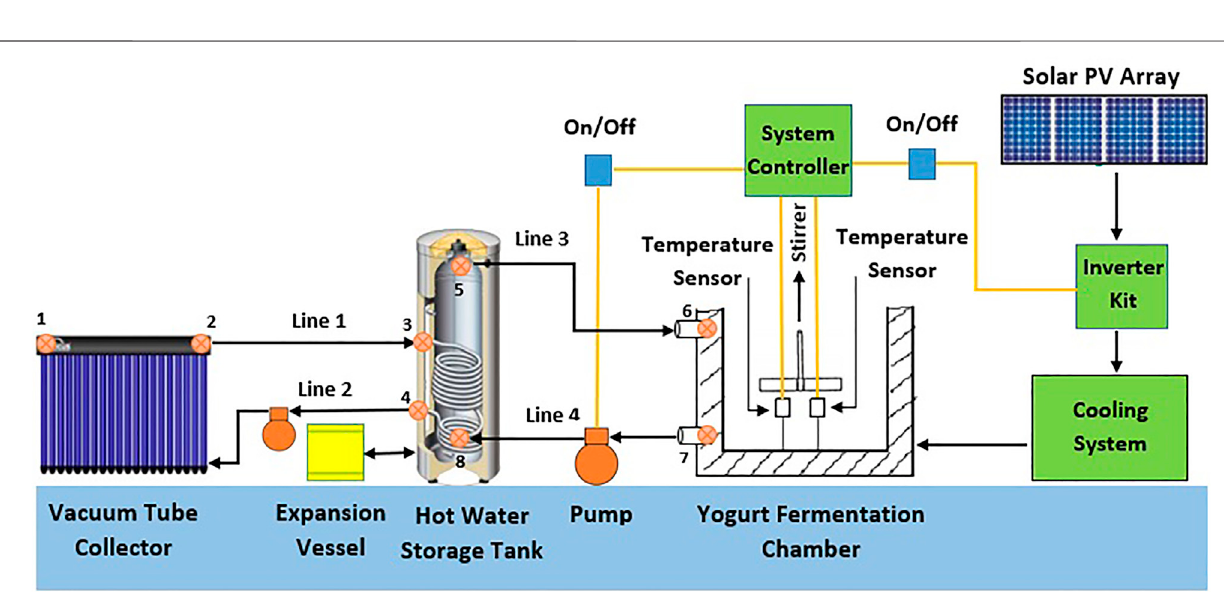
Frontiers in Energy Research |